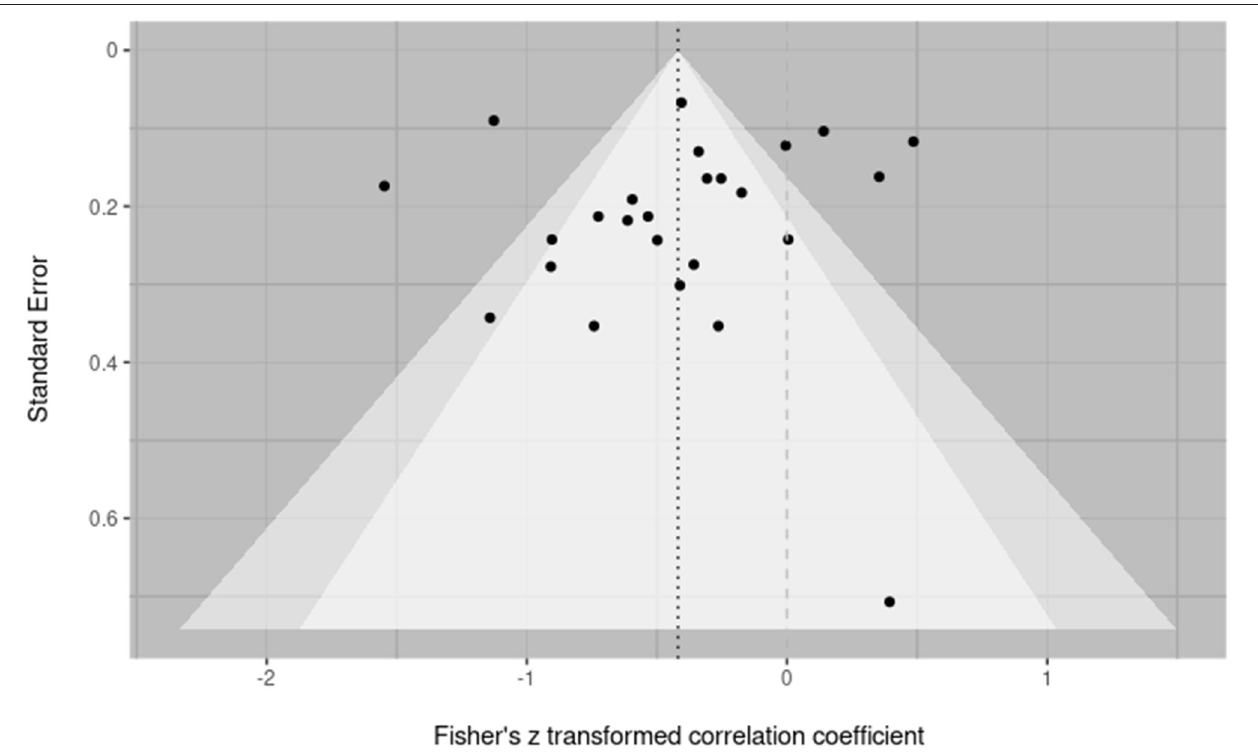
FIGURE 4 | Contoured funnel plot of effect sizes aggregated by paper. Fisher’s Z transformed correlation coefficients for each reported effect size are plotted against the standard error. The dark dashed line indicates the summary effect size on which the funnel is centered. The lighter dashed line indicates a null effect. The funnel is centered on the summary effect size. Egger’s regression suggests no asymmetry present in the plot (z = -0.4545, p =